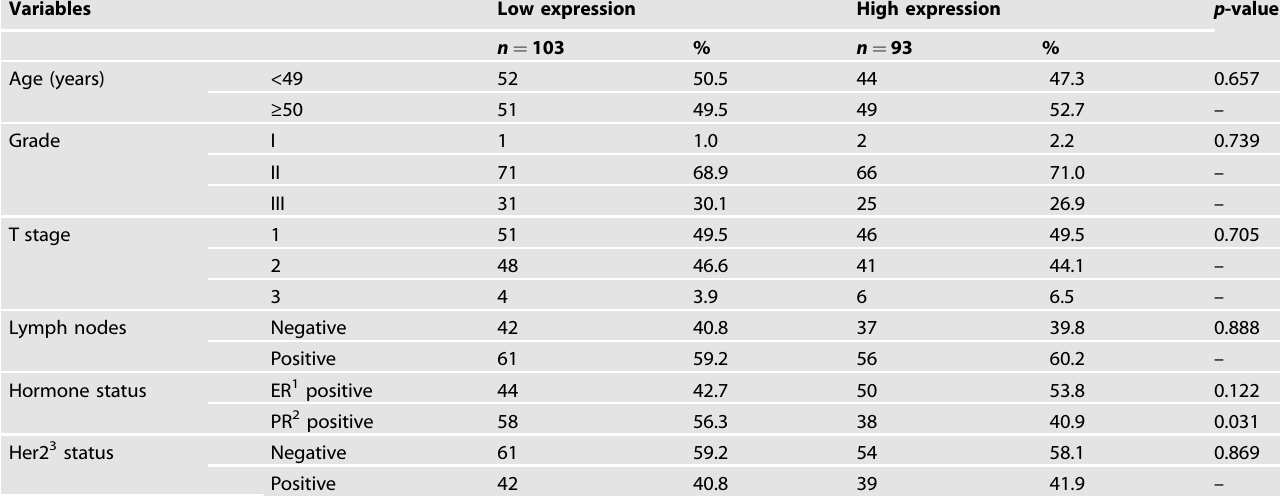
Table 1. The correlation between DGKZ expression and clinicopathological characteristics.